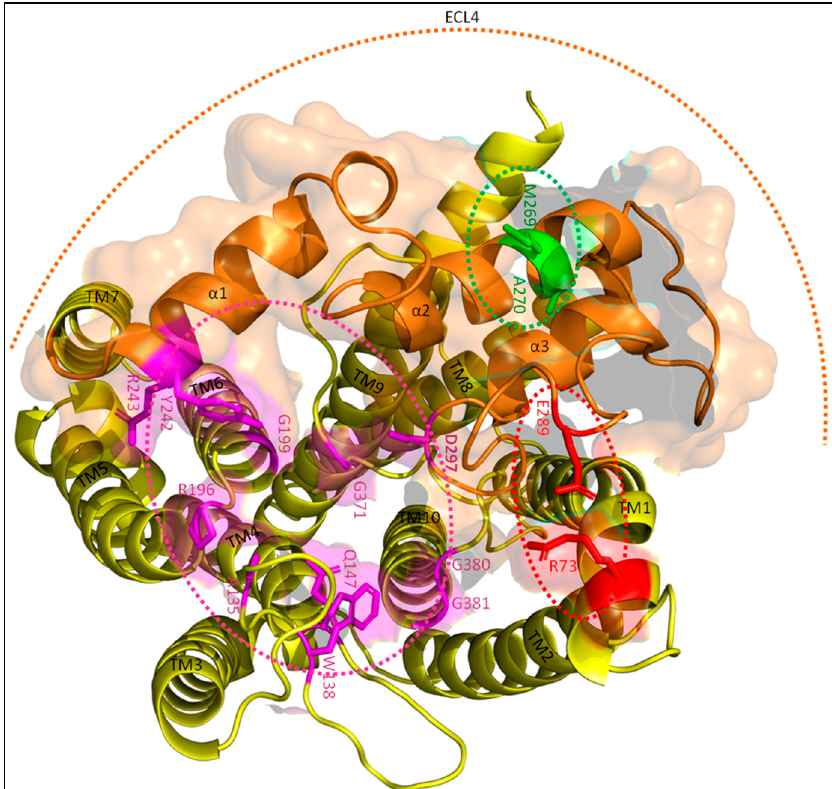
Figure 4. FtsW active site. A single FtsW protein (yellow) is shown from above in the periplasm. The active site is indicated by the magenta–dotted ellipse with active site residues also highlighted in magenta. The ECL4 (orange) contains the putative catalytic residue D297, a region around M269 (green) that activates FtsW, and another region around E289 (red) that inhibits FtsW. E289 forms a putative interaction with R73 in this prediction. α 1, α 2 and α 3 indicate the three α -helixes of ECL4. The FtsI interaction interface is highlighted in transparent orange. The active site residues are from the paper of Li et al. [67].